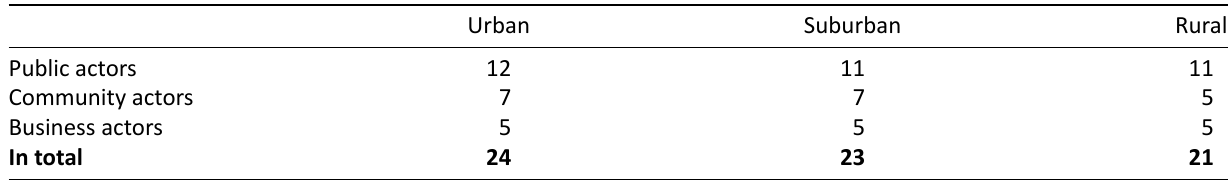
Table 1. Size and structure of the sample.